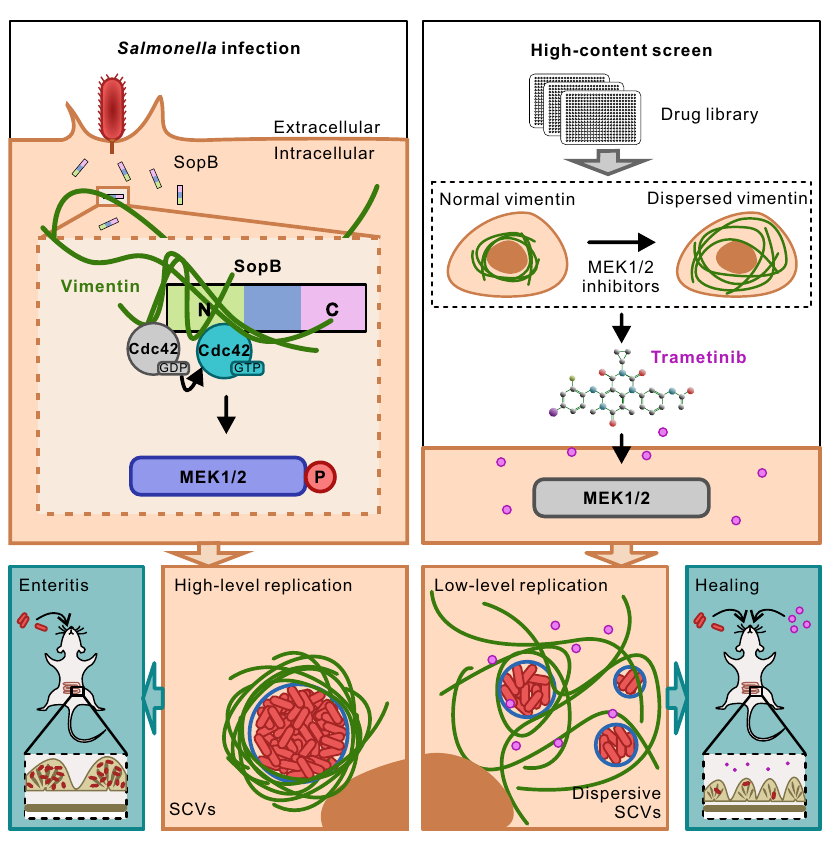
Fig. 7 | Schematic summary of Salmonella effector SopB reorganizes cytoske- letal vimentin for ef fi cient infection. Bacterial SopB targets vimentin by its N terminal Cdc42-binding domain to maintain concrete replication vacuoles